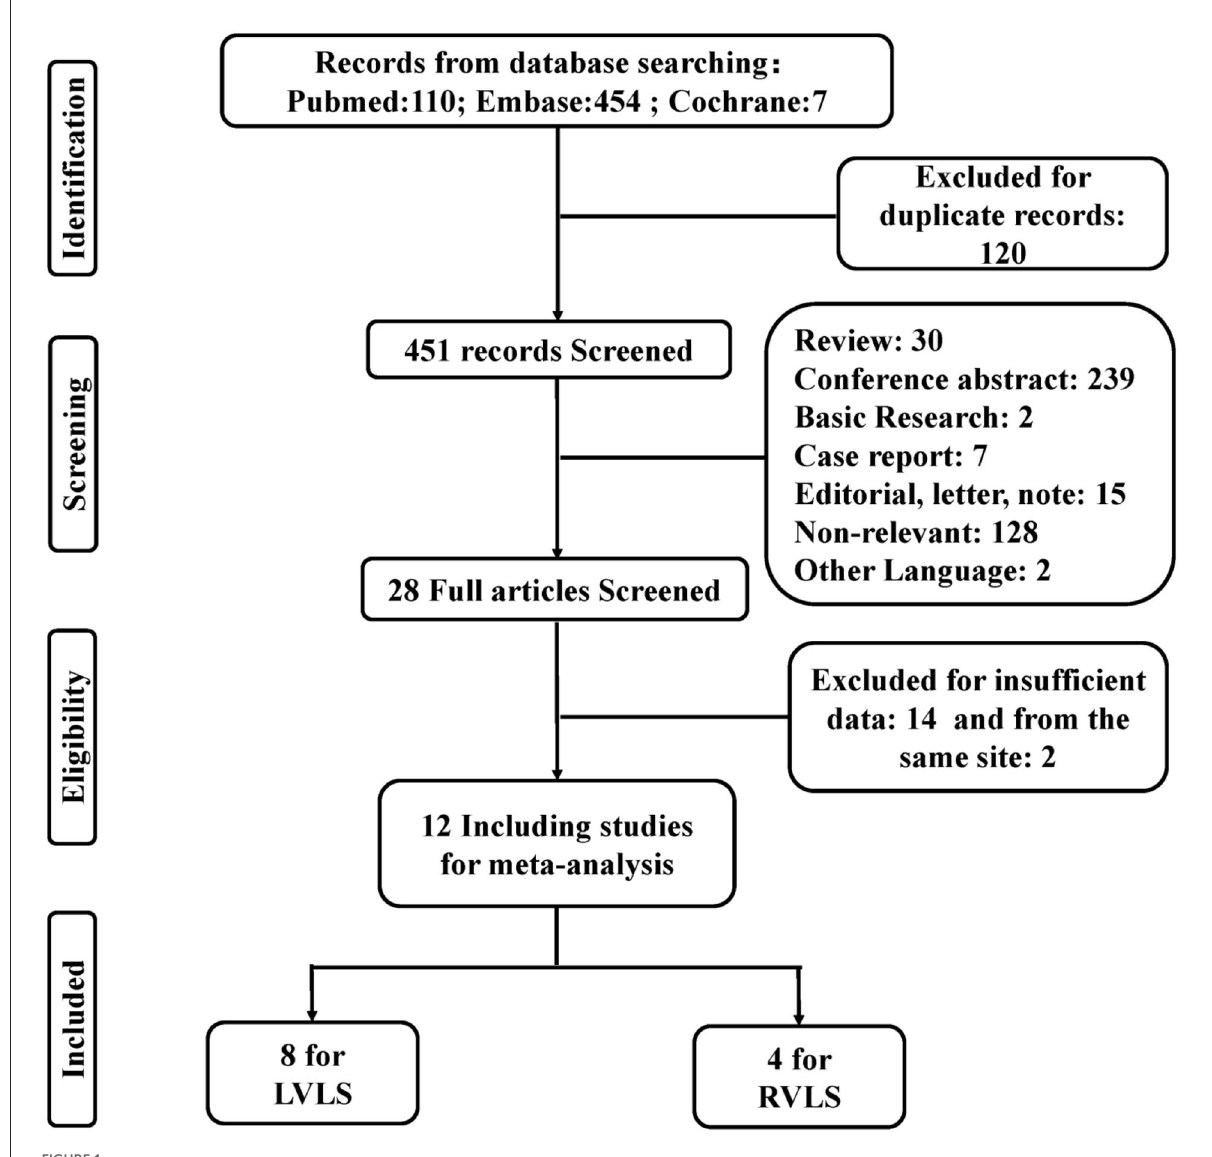
FIGURE1 Flow diagram of literature